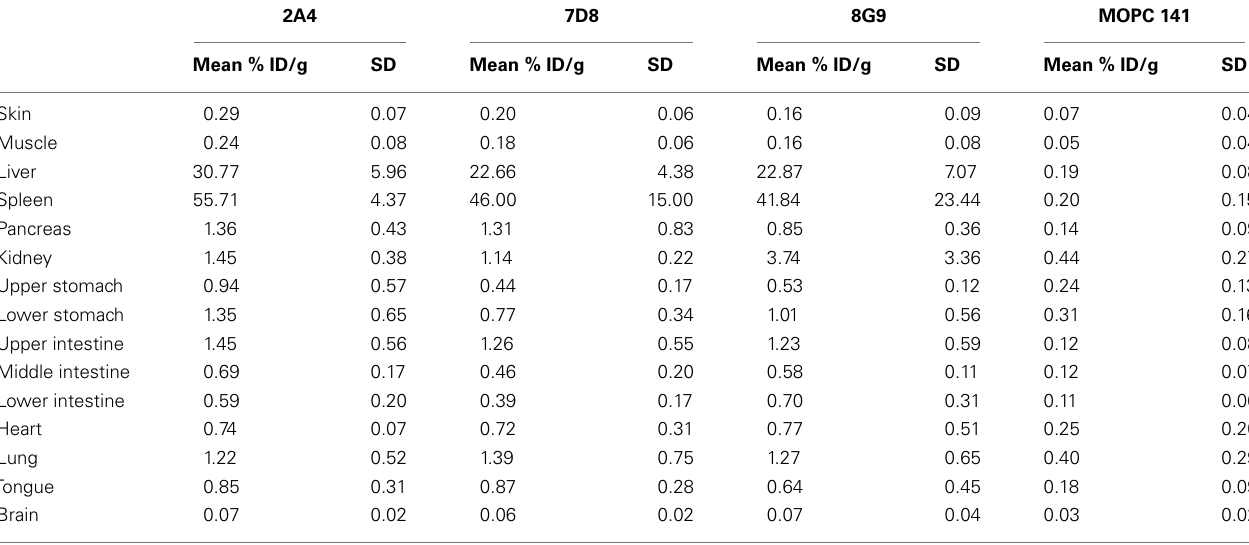
Table 2 | Biodistribution of radiolabeled mAbs inAA amyloidotic or control mice.